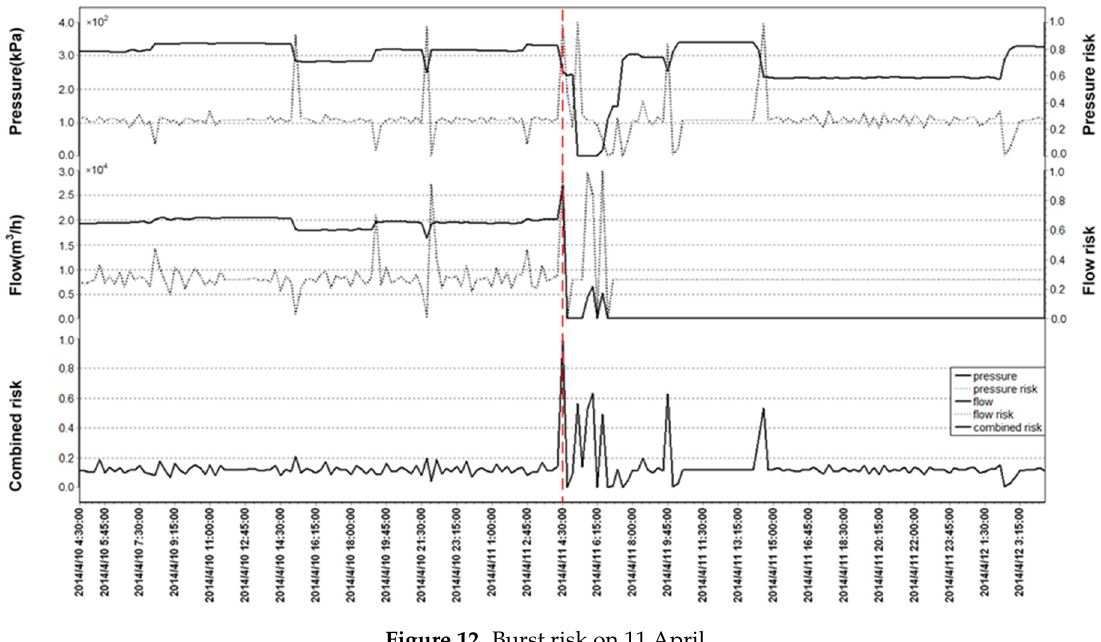
Figure 12. Burst risk on 11 April. Water 2018 , 10 , 18 FOR PEER REVIEW